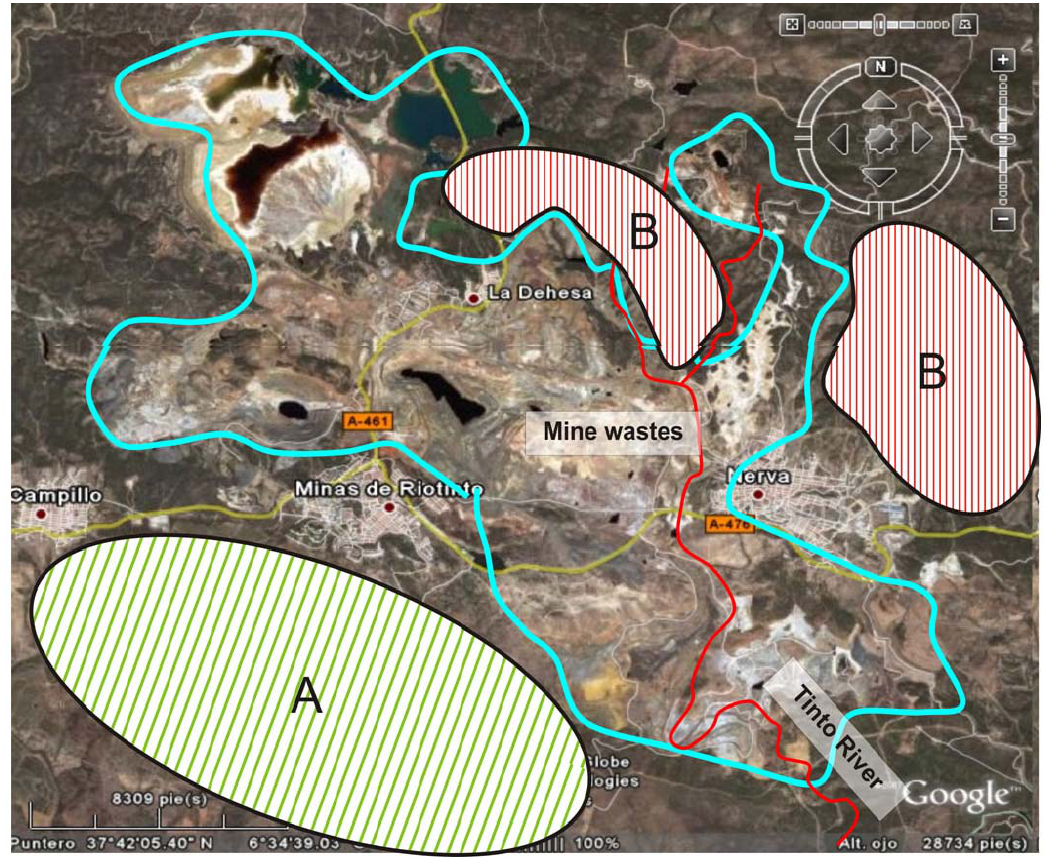
Figure 8. Distribution of agricultural soils around mine wastes and potential hazard according to the bioavailability. In green, suitable area for agriculture; in red, potentially hazardous